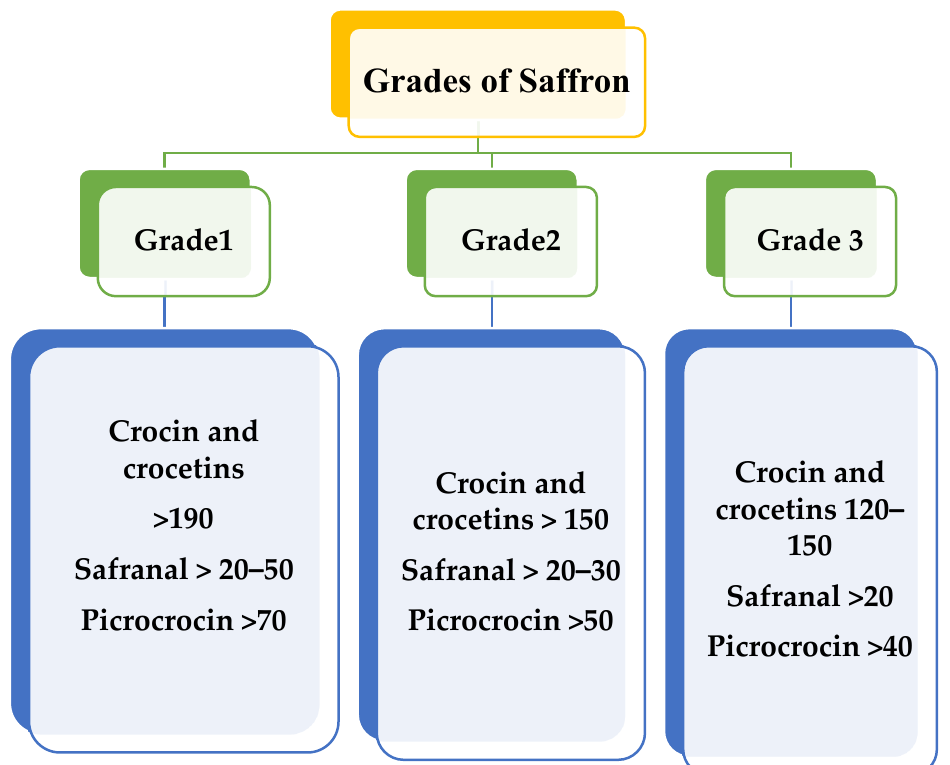
Figure 1. Grades of saffron based on quality traits.